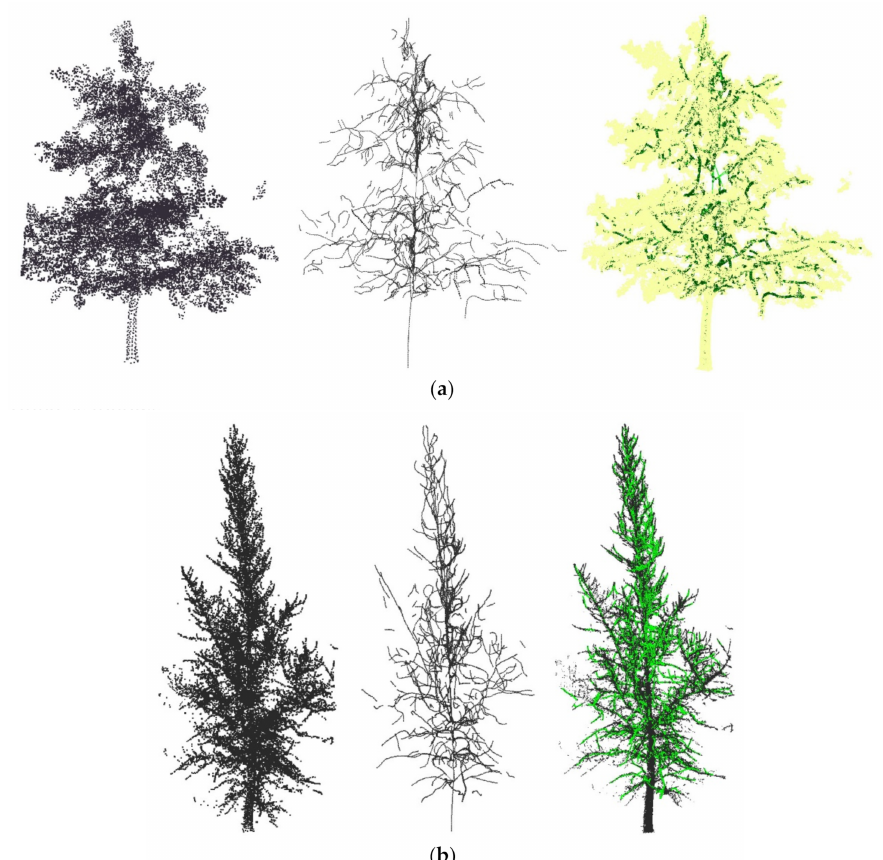
Figure 7. Results of two di ff erent trees obtained using our method. From left to right: Seed point cloud, skeletons, skeletons (green) coincided with original point cloud. ( a ) Results of Data 1, ( b ) results of Data